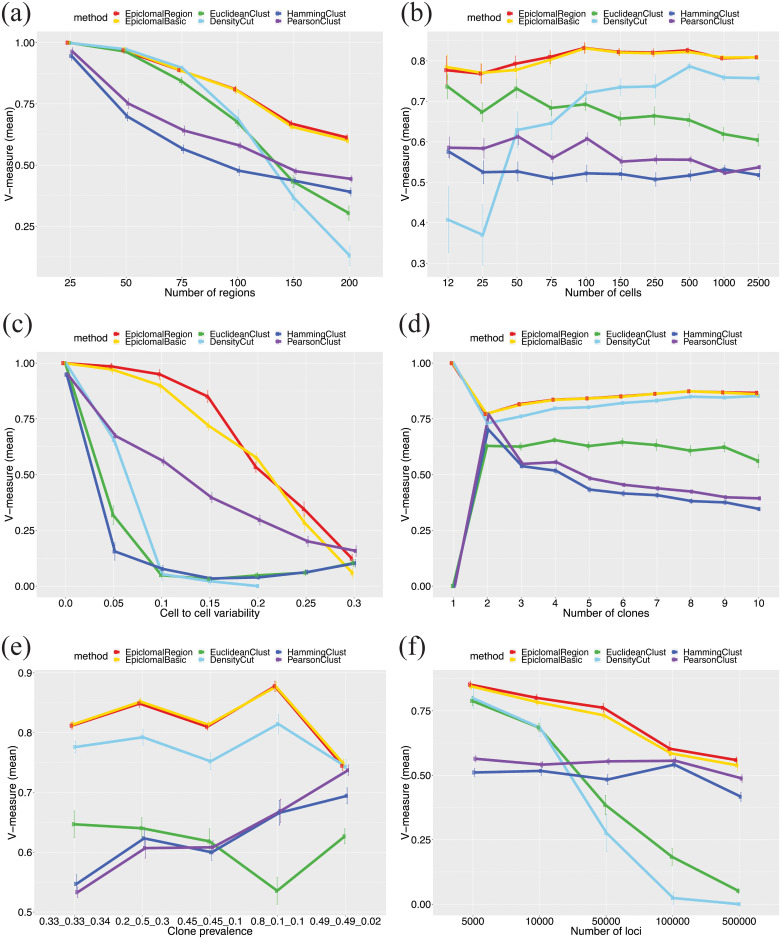
Predicted cell-to-cluster assignments on synthetic data.We report mean V-measures produced by Epiclomal and the non-probabilistic methods taken over 30 randomly generated synthetic data sets, when we vary by: (a) the number of regions, (b) the number of cells, (c) the cell-to-cell variability, (d) the number of clones, (e) the cluster frequencies (prevalences), and (f) the number of loci. The vertical bars correspond to one standard deviation above and below the mean value. The Epiclomal methods outperformed the other methods in all cases.